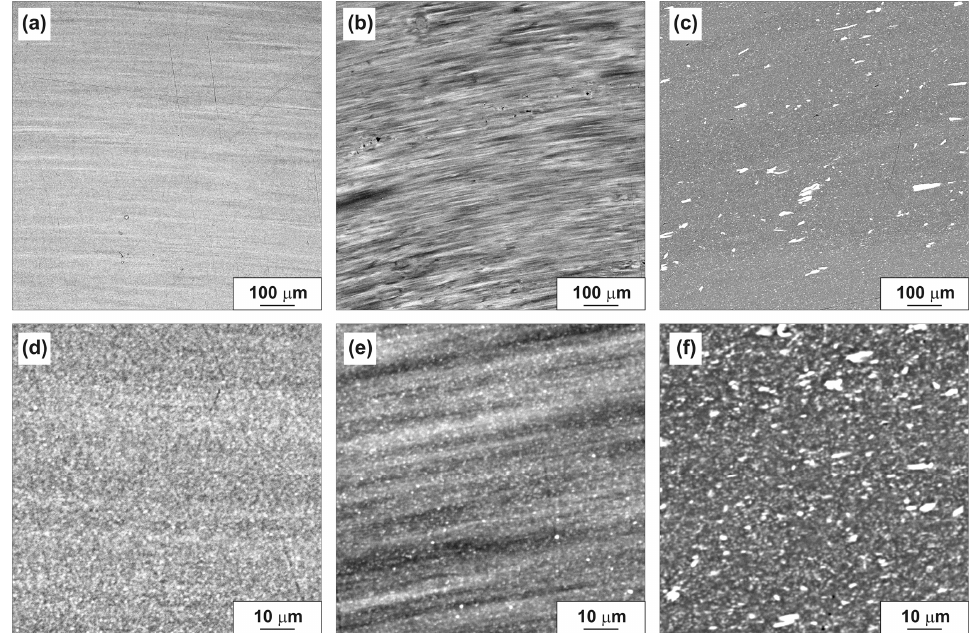
Figure 6. SEM images of the HPT-processed alloy surfaces: ( a , d ) Al–10% La; ( b , e ) Al–9% Ce; ( c , f ) Al–7% Ni. Materials 2021 , 14 , x FOR PEER REVIEW